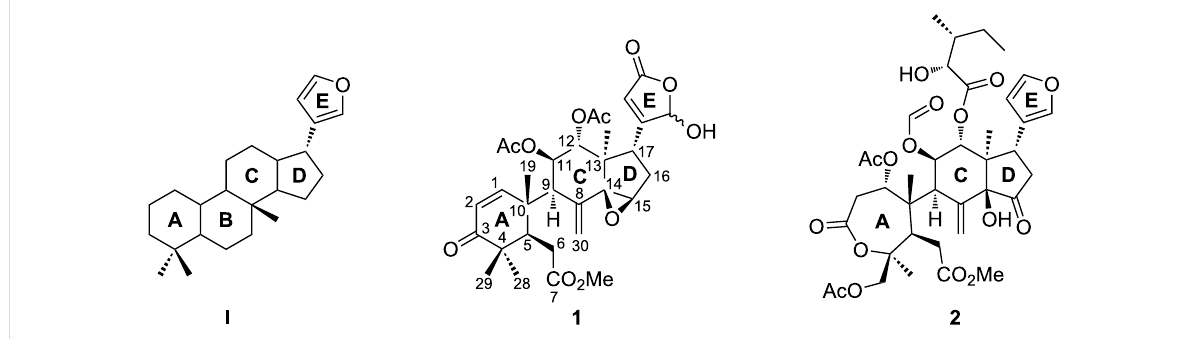
Figure 1: Structures of the 4,4,8-trimethyl-17-furanylsteroid core structure I and the representative B- seco limonoids 21-hydroxytoonacilide ( 1 ) and prieurianin ( 2 ).